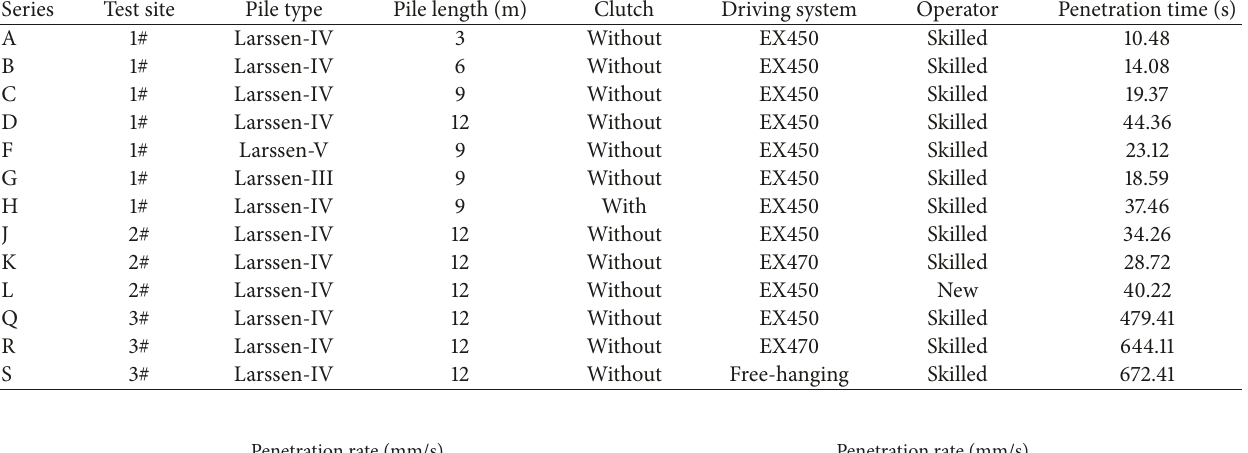
Table 4: Summary of field tests.